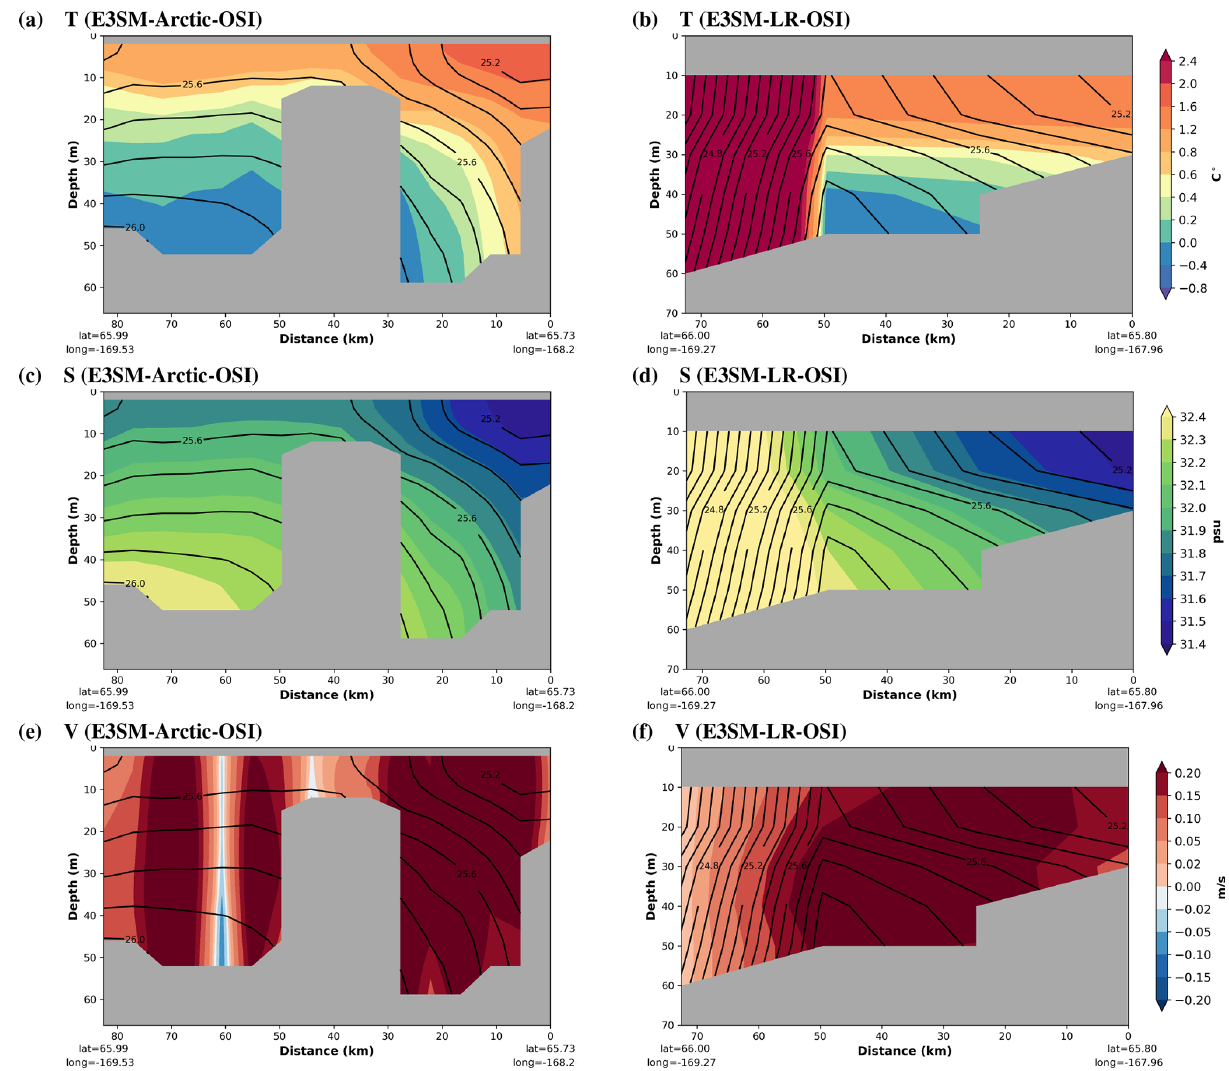
Figure 13. Similar to Fig. 10 but for the Bering